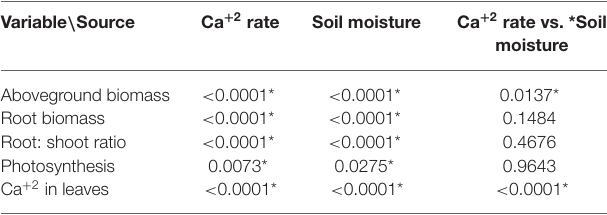
TABLE 3 | Pr > F -values from the statistical output (Anova, 5%) for influence of the Calcium (Ca + 2 ) rates and soil moisture levels on the biomass